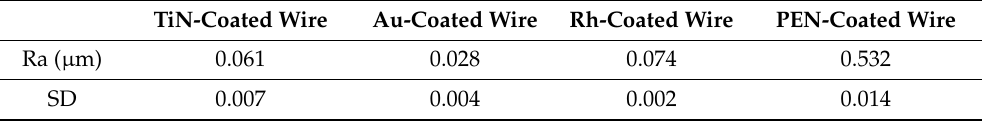
Table 1. Surface roughness of coated